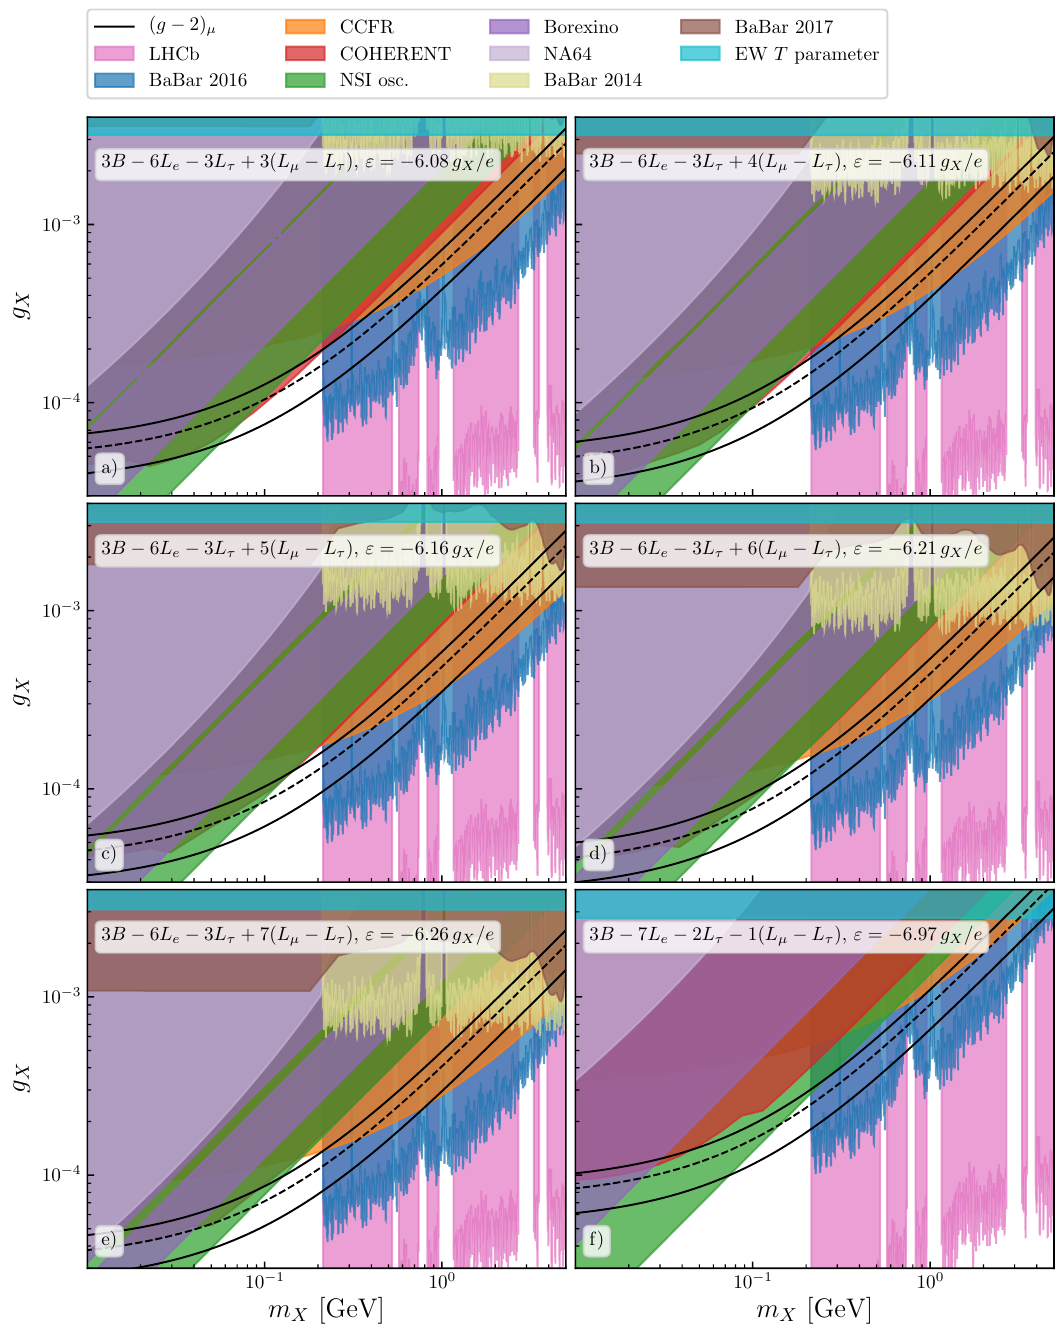
Figure 5 . Parameter space of viable vectorlike U(1) X models that can explain ( g − 2) µ (the parameter space for L is shown in figure 3). The central value of ∆ a µ − L τ dashed black line (the 2 σ band by solid black lines). The exclusions by different measurements are color coded as given in the